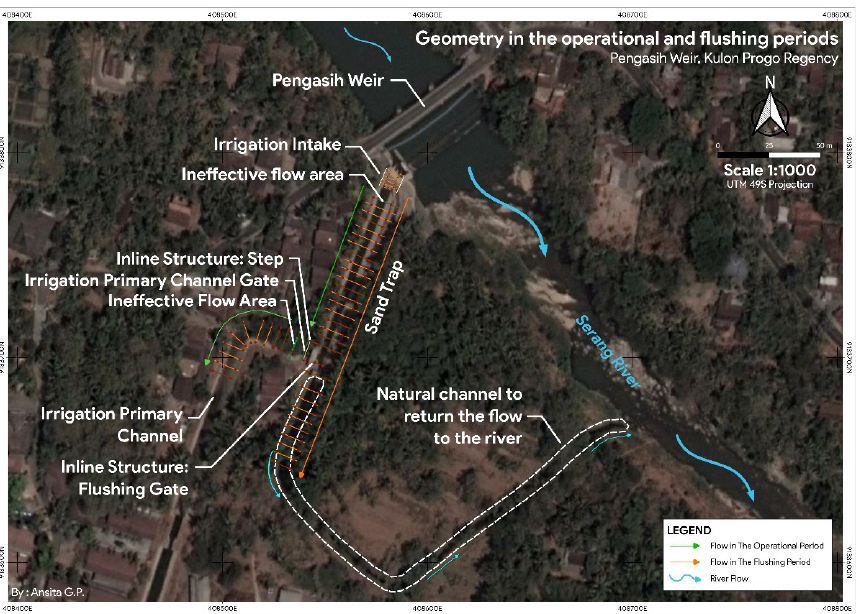
Figure 8. Geometry in the operational and flushing periods. The green arrow denotes the flow direction in the operational period. The geometry in this period was used for hydraulic calibration and validation. We modeled an inline structure in the form of a step and equipped with gates before entering the irrigation primary channel. Additionally, we placed the ineffective flow area right after the irrigation intake and step. The orange arrow depicts the flow direction during the flushing period. The geometry in this period was used to calibrate the sediment. We modeled an inline structure in the form of gate (flushing gate) before entering the natural channel to return the flow to the river.